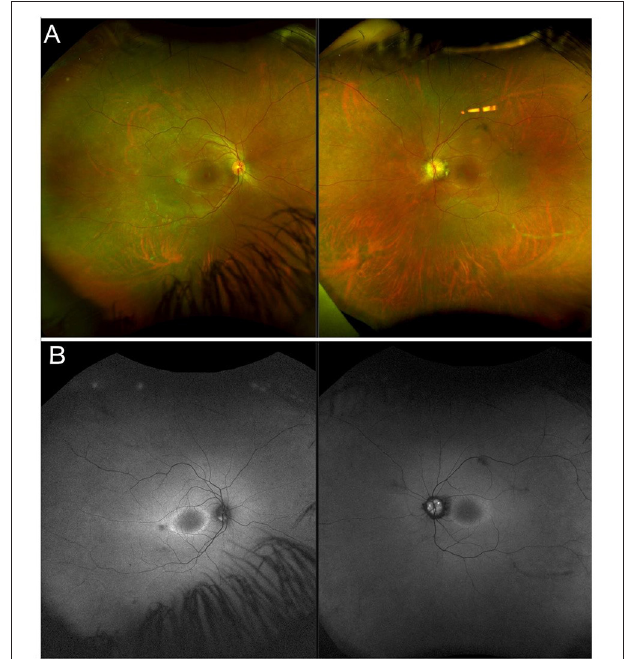
FIGURE 2 | Multimodal imaging in a patient with a non-syndromic USH2A-related form of RP. (A) Ultra-wide field retinography shows near complete absence of pigment bone spicules. (B) Fundus autofluorescence displays the typical perifoveal ring of